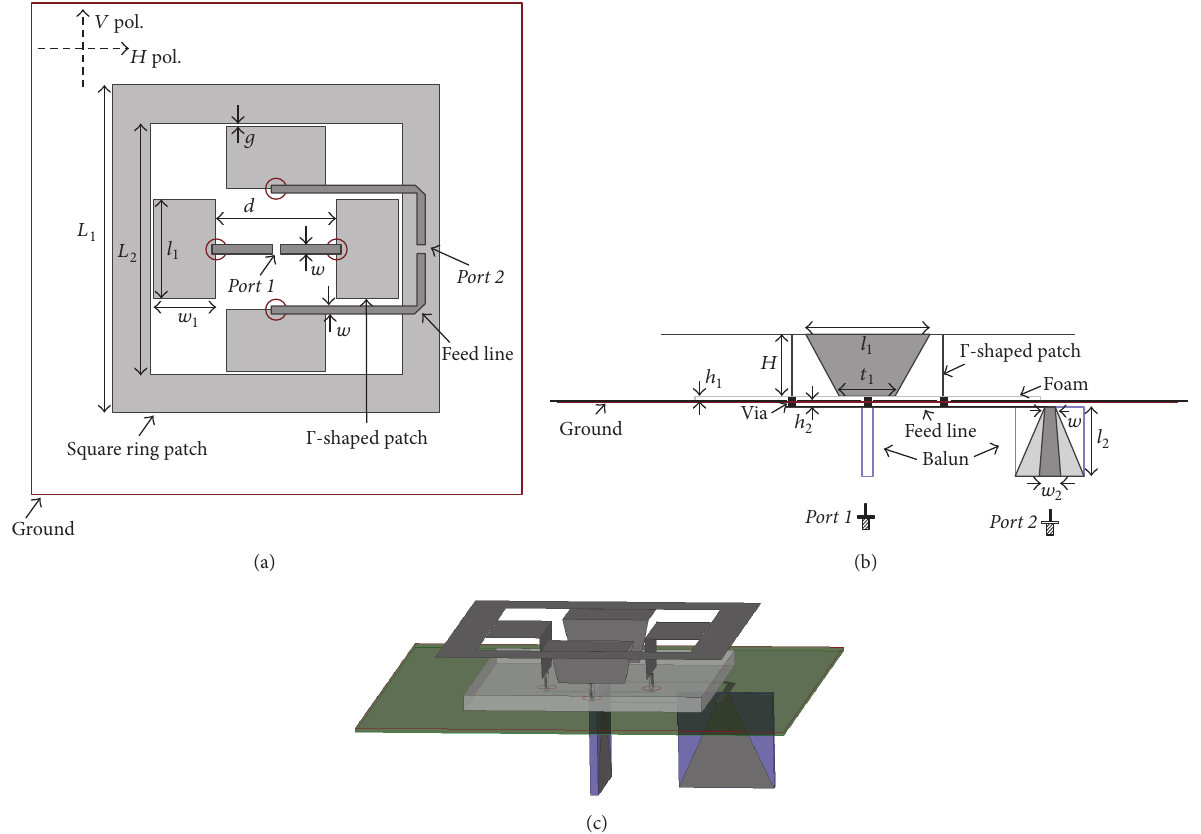
Figure 5: Construction of the proposed dual-polarized UWB antenna: (a) top view, (b) side view, and (c) 3D view. 𝐿 1 = 65mm, 𝐿 2 = 45 mm, 𝑤 𝑡 𝑑 = 22 mm, 𝑔 = 0.1mm, 𝑤 = 1.5 mm, 𝑤 𝑙 1 = 18 mm, 1 = 11.3mm, 1 = 14mm, 0.8 mm.